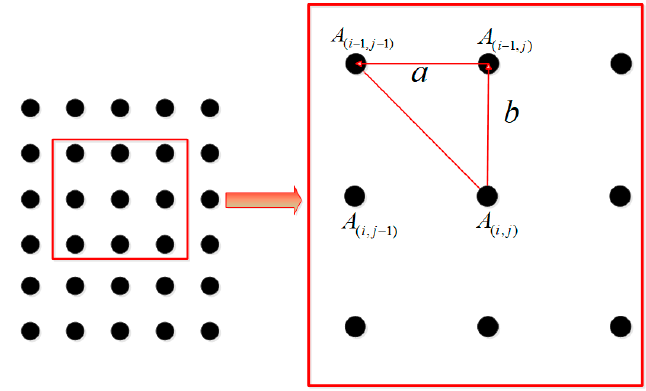
Figure 7. Schematic diagram of weighted median filtering principle.